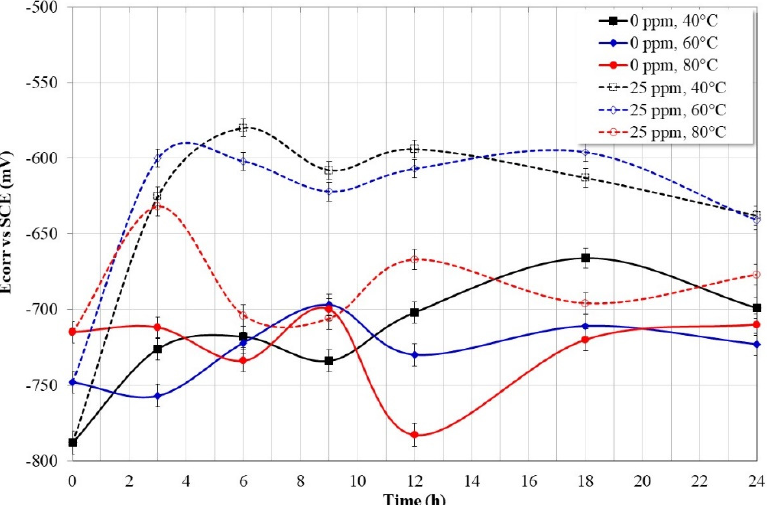
Figure 12. Corrosion potential variation for API-X52 steel in 3% NaCl solution saturated with CO 2 , determined from potentiodynamic polarization curves.